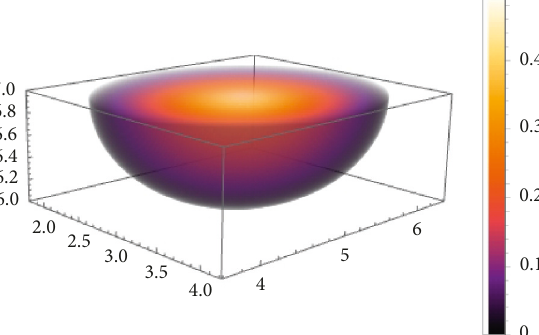
Figure 9: AB 2 D a − cut